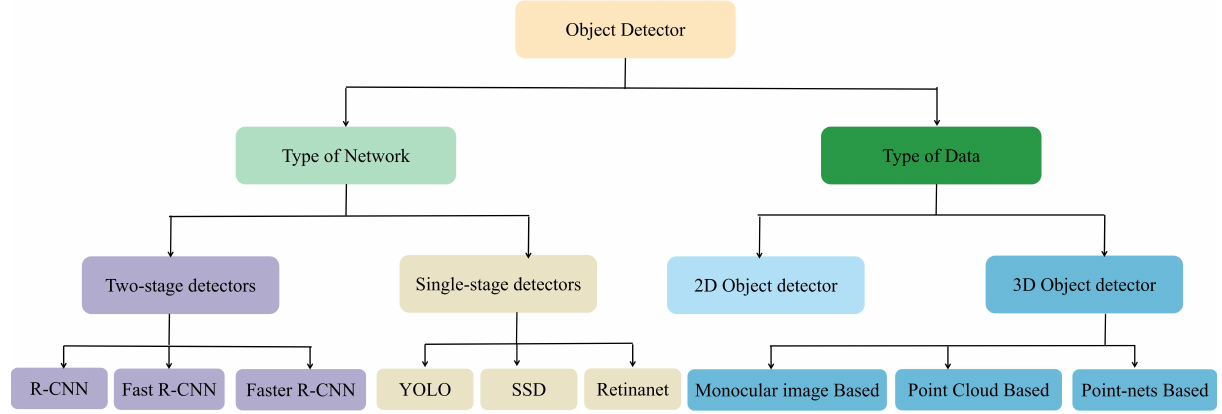
Figure 3. Classification of object